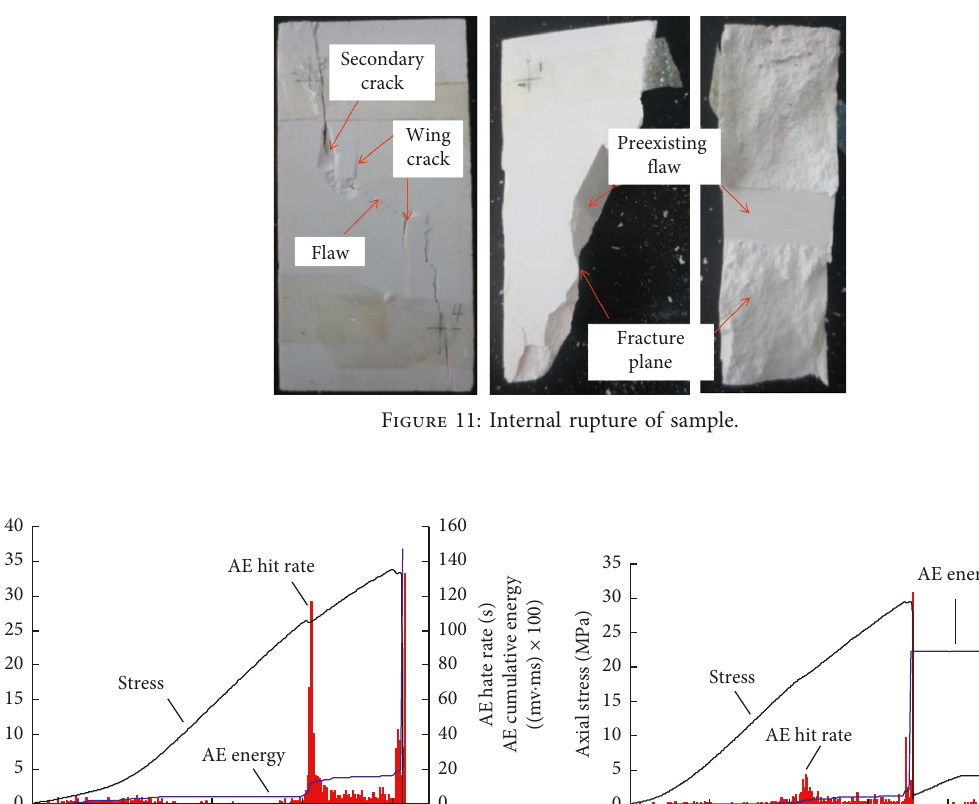
Figure 10: Failure modes of specimens containing a single flaw with different inclination angles under uniaxial compression: (a) α (b) α 45 ° ; (c) α 60 ° ; (d) α 75 ° . (cid:29) (cid:29) (cid:29)